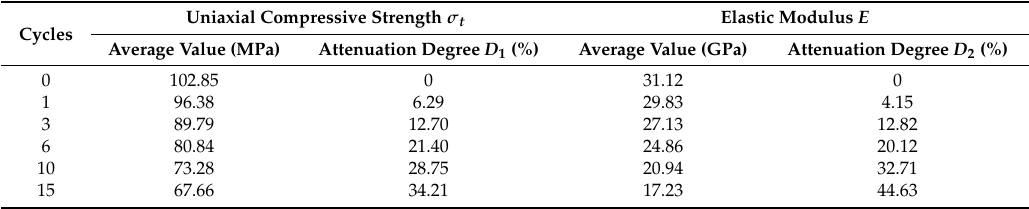
Table 2. Statistics of experimental results for rock uniaxial